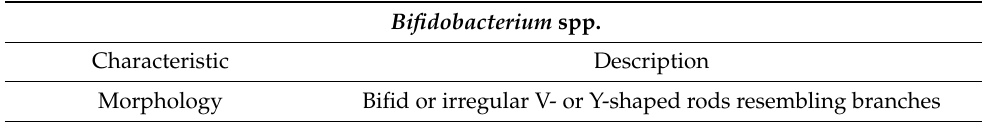
Table 6. Characteristics of Bifidobacterium